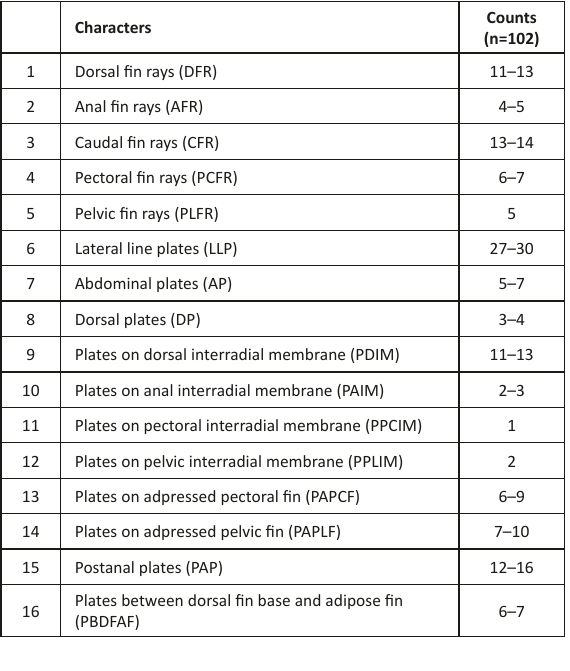
Table 2. Morphometric characteristics of Pterygoplichthys disjunctivus and P. pardalis